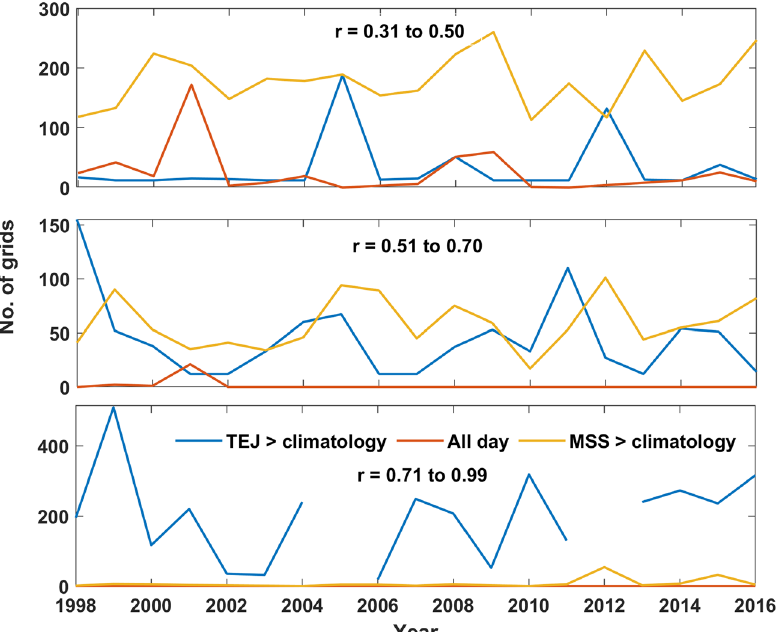
Figure 6. Number of grids in different correlation value (r) when TEJ/MSS > climatology and for all 122 days during SW